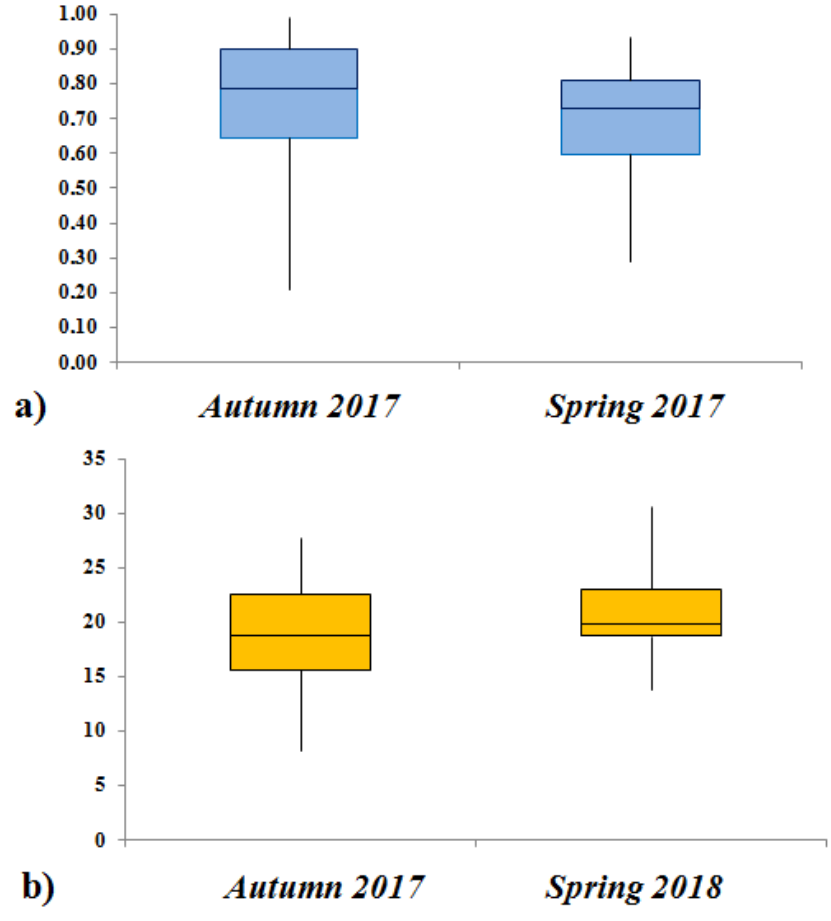
Figure 7. Box plot (median, range and interquartile ranges) of RETI ( a ) and ITC ( b ) index values during the study period. Legend: x-axis–sampling season; y-axis–indices values.